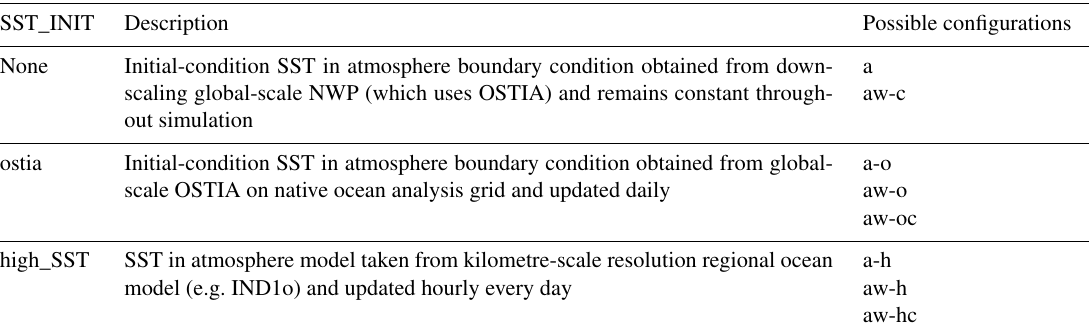
Table 4. Summary of the different SST initialization and updating options available within the RCS, applicable for model configurations in which there is no dynamic coupling to an ocean model. Options are controlled using the SST_INIT environment